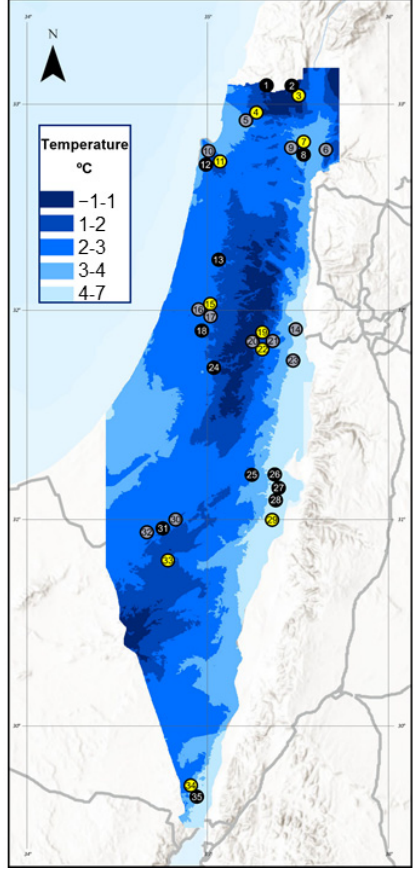
Figure 1. Distribution of the 35 caves included in this study. A blue overlay is given to represent the mean minimum temperature in January (the coldest month of the year) over the 20 years preceding 2021. Dark blue and light blue denote low and high minimum temperatures, respectively. Caves with both twilight and dark zones are denoted by black dots, caves with twilight zones but not dark zones are denoted by grey dots, and caves lacking both twilight and dark zones are denoted by yellow dots. Numbers denote specific cave identities related to numbers assigned by Gavish-Regev et al. [19].